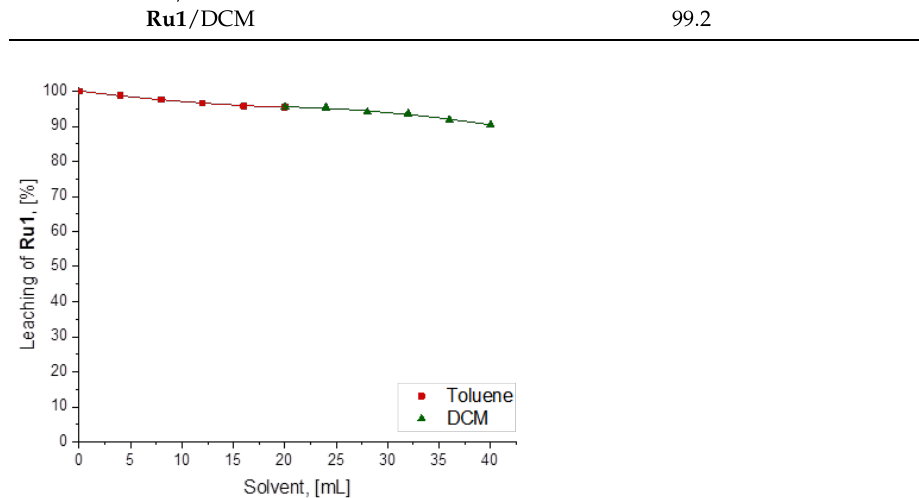
Figure 3. Desorption of Ru1 catalyst from (Al)MIL-101-NH 2 by subsequent washing with toluene and later with DCM.